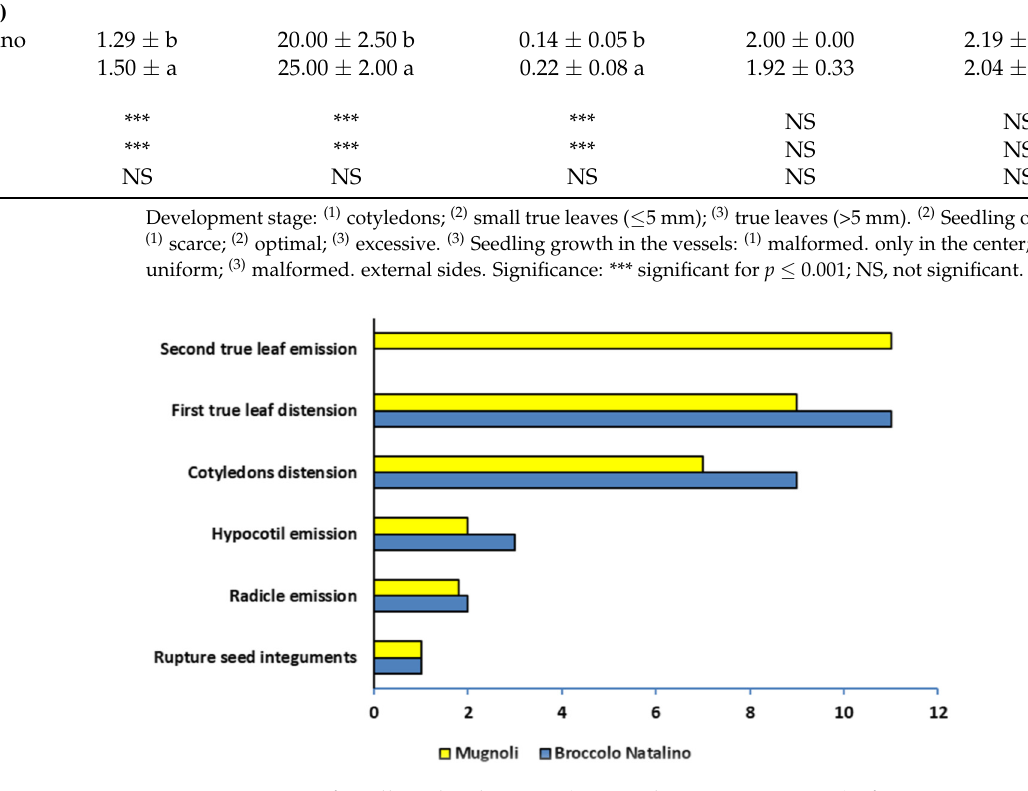
Figure 4. Timing of seedling development (in greenhouse environment) of two Brassica microgreens: Mugnoli and Broccolo Natalino.